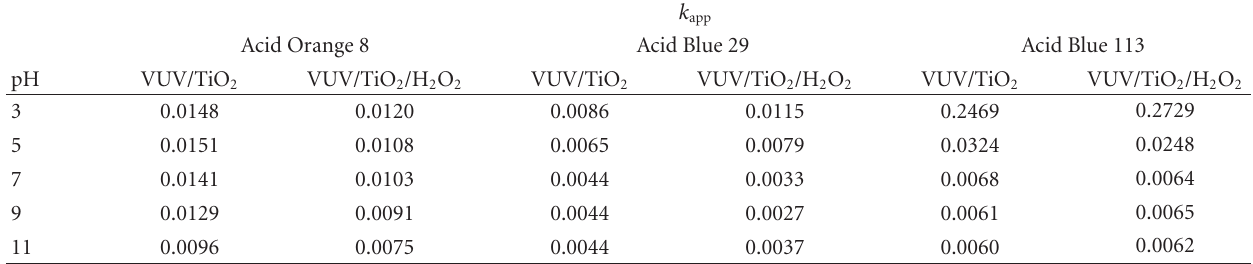
Table 3: The k app (min − 1 ) values at di ff erent pH in both VUV/TiO 2 and VUV/TiO 2 /H 2 O 2 process.